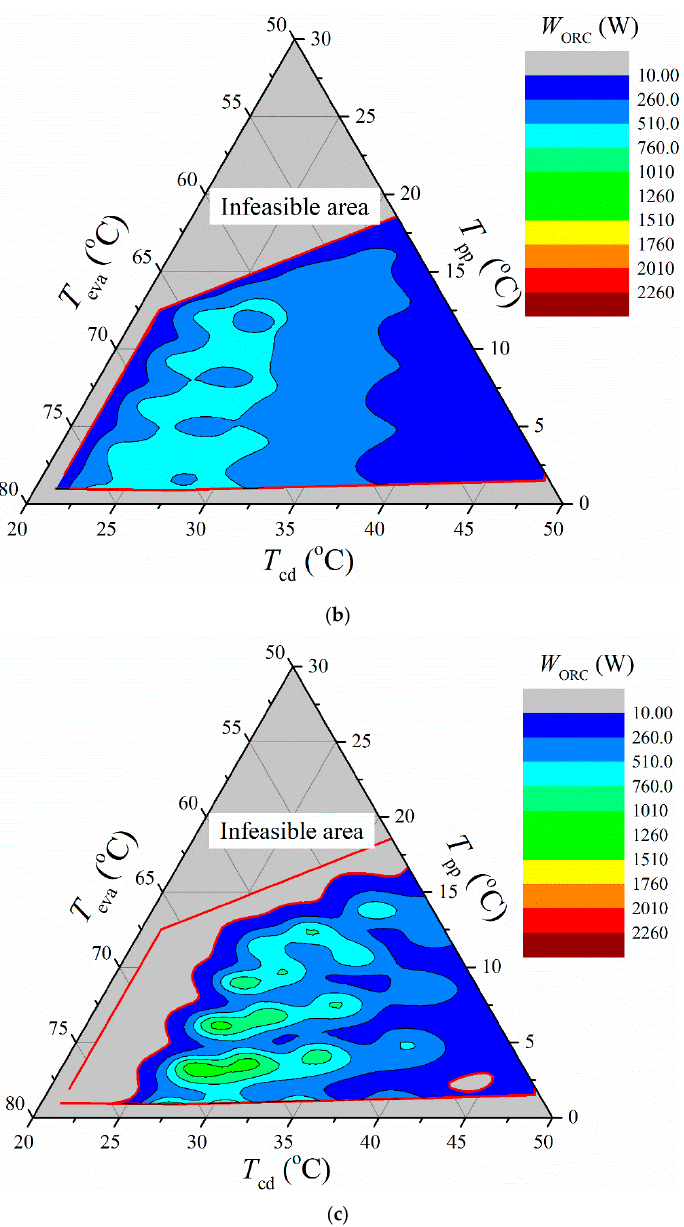
. m wf ∈ [ 0.029kg/s,0.120kg/s ] ;